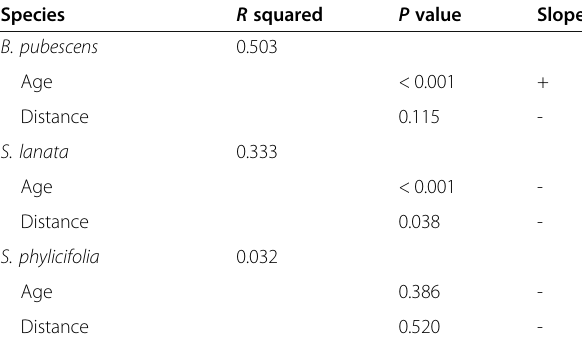
Table 4 Multiple linear regression analysis results testing data for density of specimens per m 2 against the factors of moraine age and distance from Skaftafelsheiði for B. pubescens and both Salix species